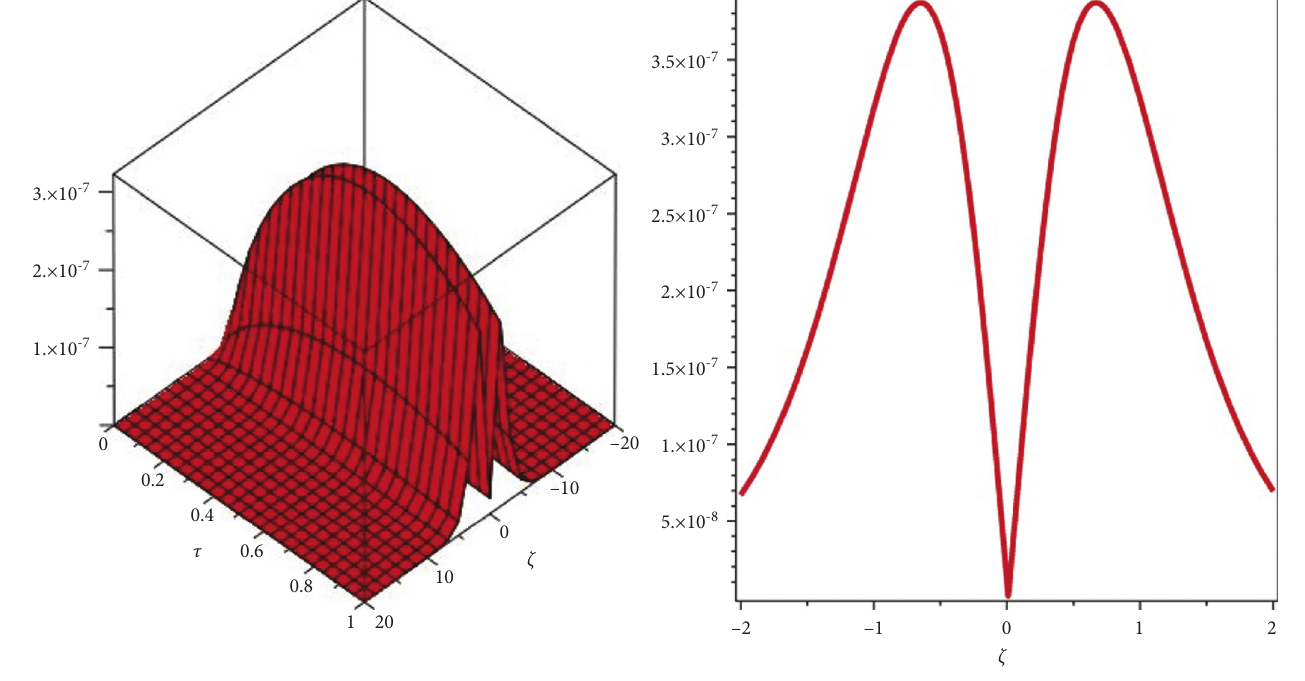
Figure 3: The 2D and 3D error plot of Problem